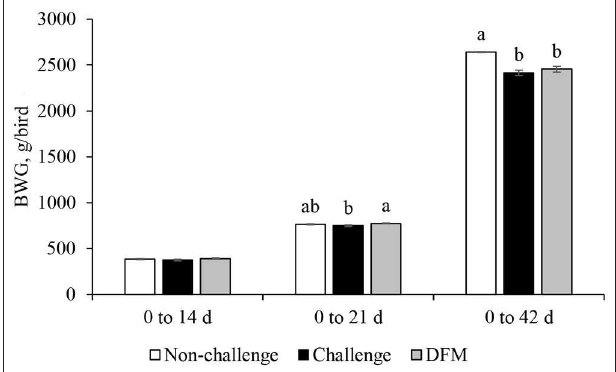
FIGURE 1 | Body weight gain (BWG) of broiler chickens fed control and treatment diets. Each bar represents the mean ± SE ( n = 7). a,b Bars with different superscripts are significantly different ( P <